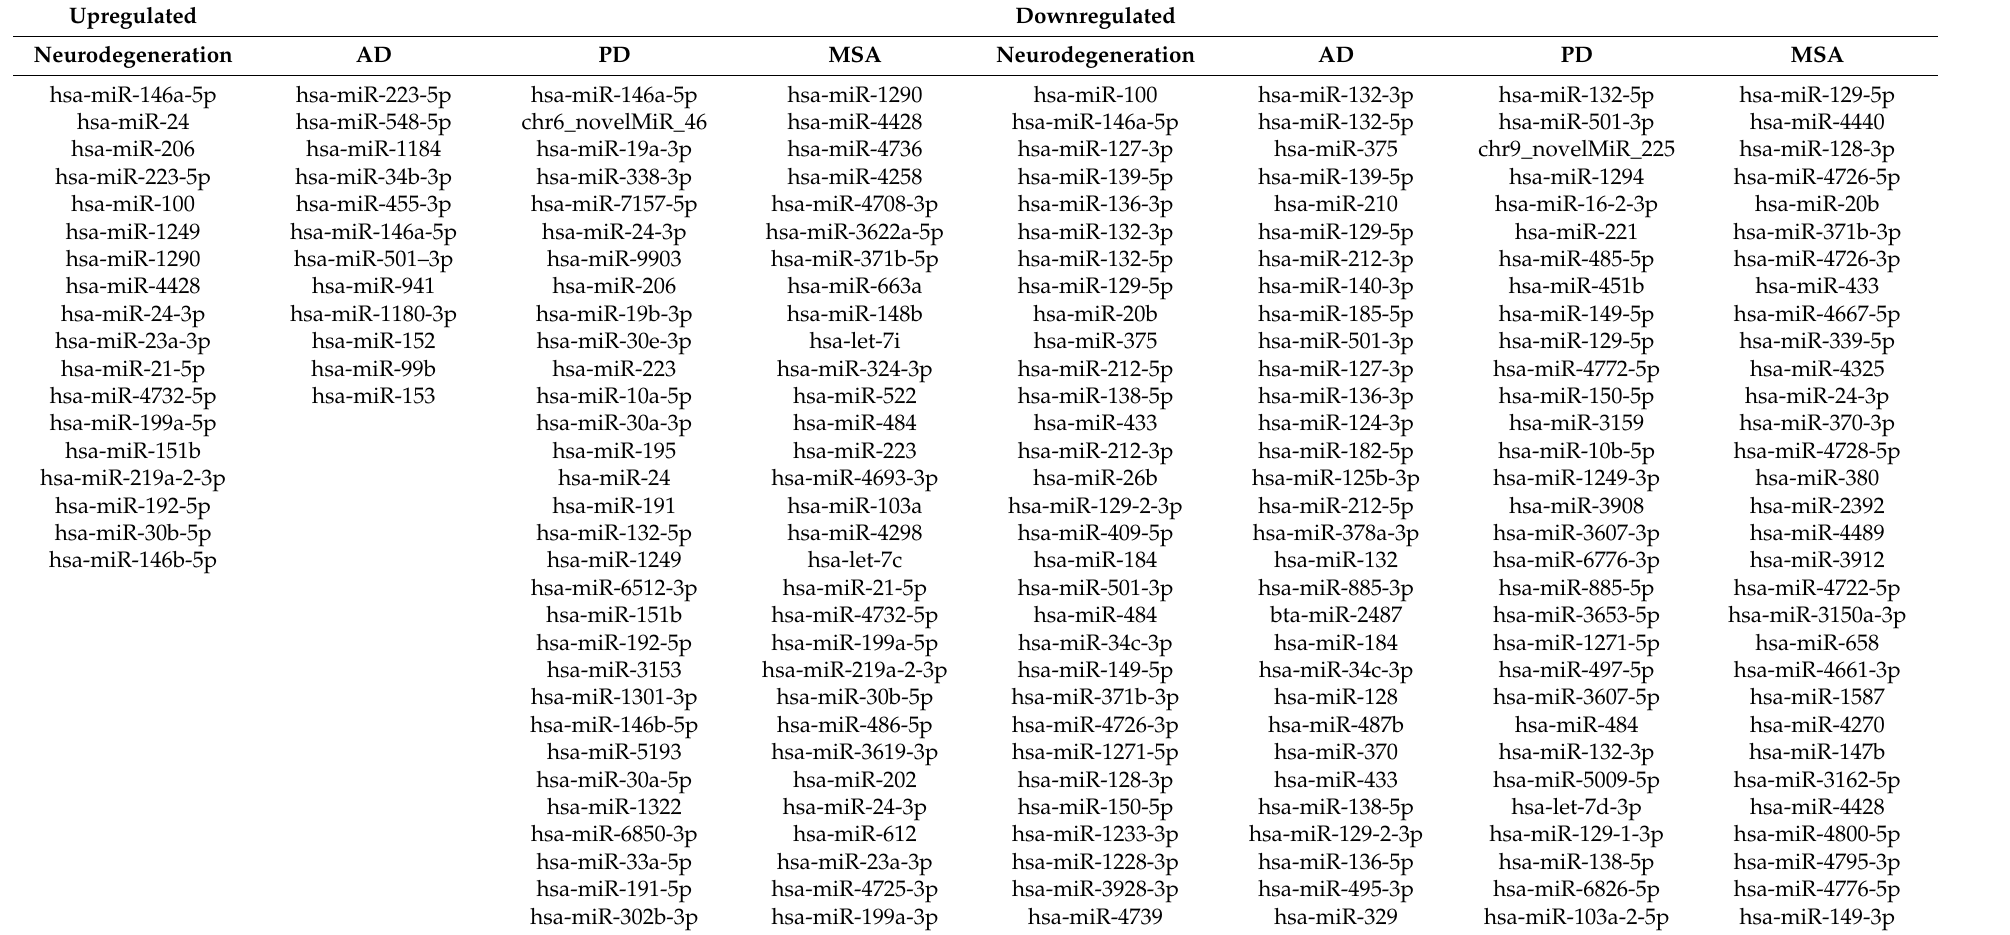
Table 2. List of consistently differentially expressed miRNAs post RRA in AD, PD, MSA and across neurodegeneration.